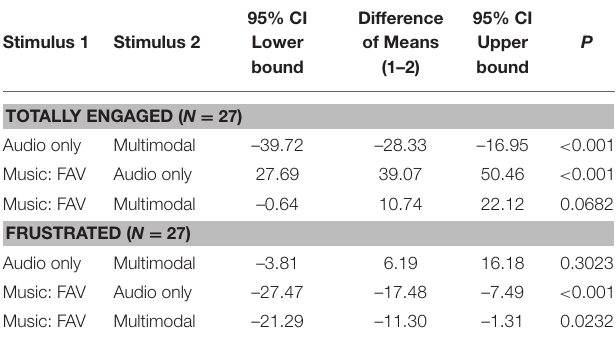
TABLE 4 | Comparison of subjective responses elicited by each category of musical stimulus. 95%